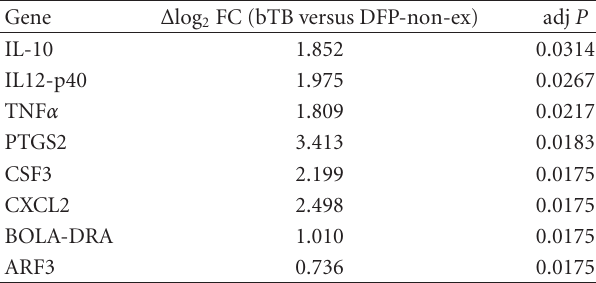
between cattle that were double antemortem test-false positive with no bTB-exposure history (DFP-non-ex) and cattle that were bTB infected (bTB), as determined by qPCR analysis. The di ff erential expression level ( Δ log 2 FC) of the bTB and DFP-non-ex groups of cattle (bTB minus DFP-non-ex) was determined using ANOVA